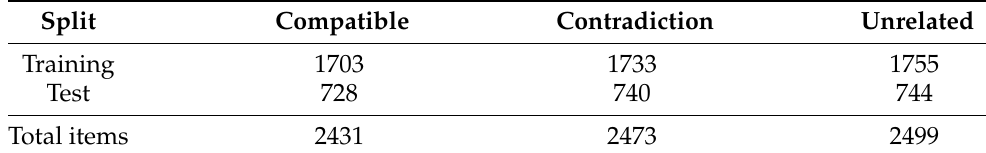
Table 1. Dataset split sizes for each class.